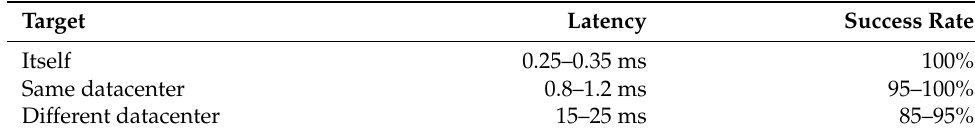
Table 3. Network metrics